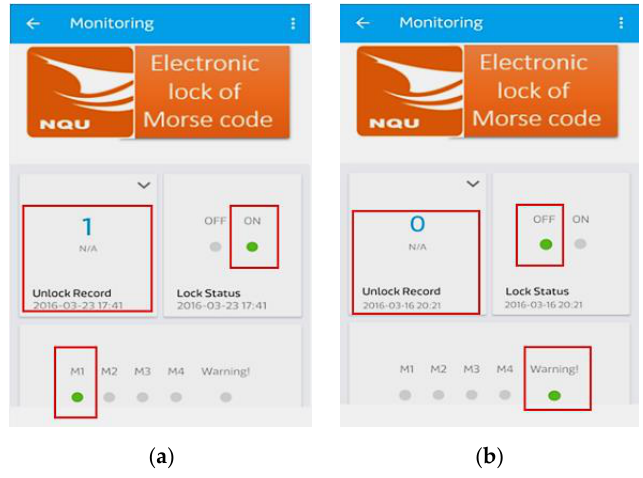
Figure 19. Lock information on the cloud monitoring system ( a ) correct password inputs; ( b ) incorrect password inputs.